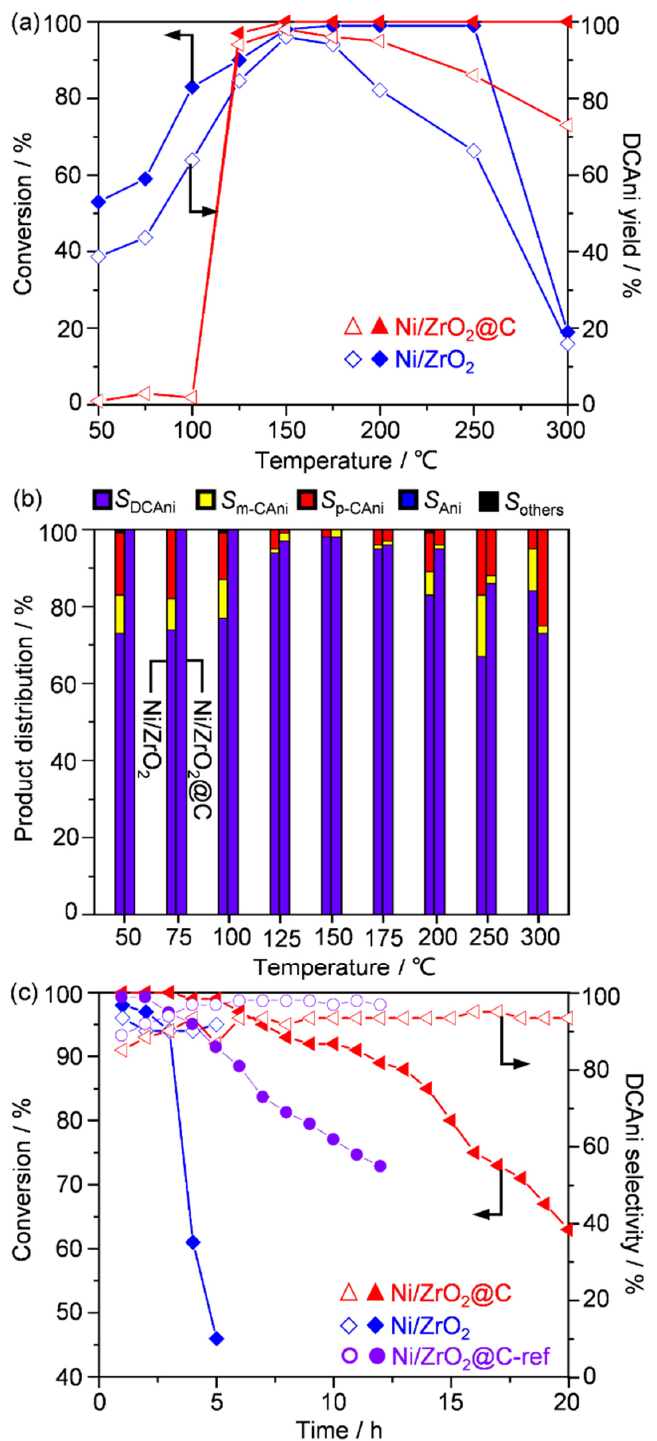
Figure 5. Catalytic performance in the continuous-flow hydrogenation of DCNB over different nickel catalysts. ( a ) The conversion and DCAni yield, and ( b ) product distribution as a function of the bed temperature. ( c ) Stability performance. Reaction conditions: P = 1 bar, ( a , b ) F H2 = 10 mL min − 1 and F liquid = 1 mL min − 1 , ( c ) F H2 = 40 mL h − 1 and F liquid = 4 mL h − 1 , and T = 200 °C. The same weight of nickel was ensured in the hydrogenation by mixing the pristine (500 mg) and pre-coked catalysts with quartz sand of similar particle size, and the total weight was fixed at 1.0 g. The liq- uid was 5 wt.% DCNB in toluene.